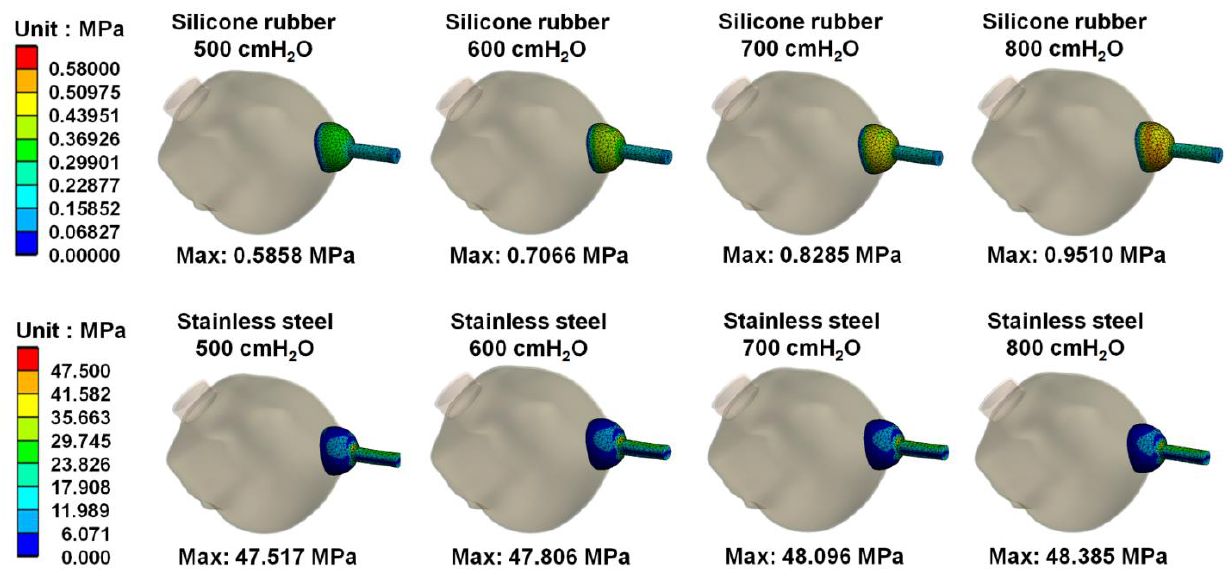
Figure 6. Distribution of von Mises stress on the vacuum extractor.